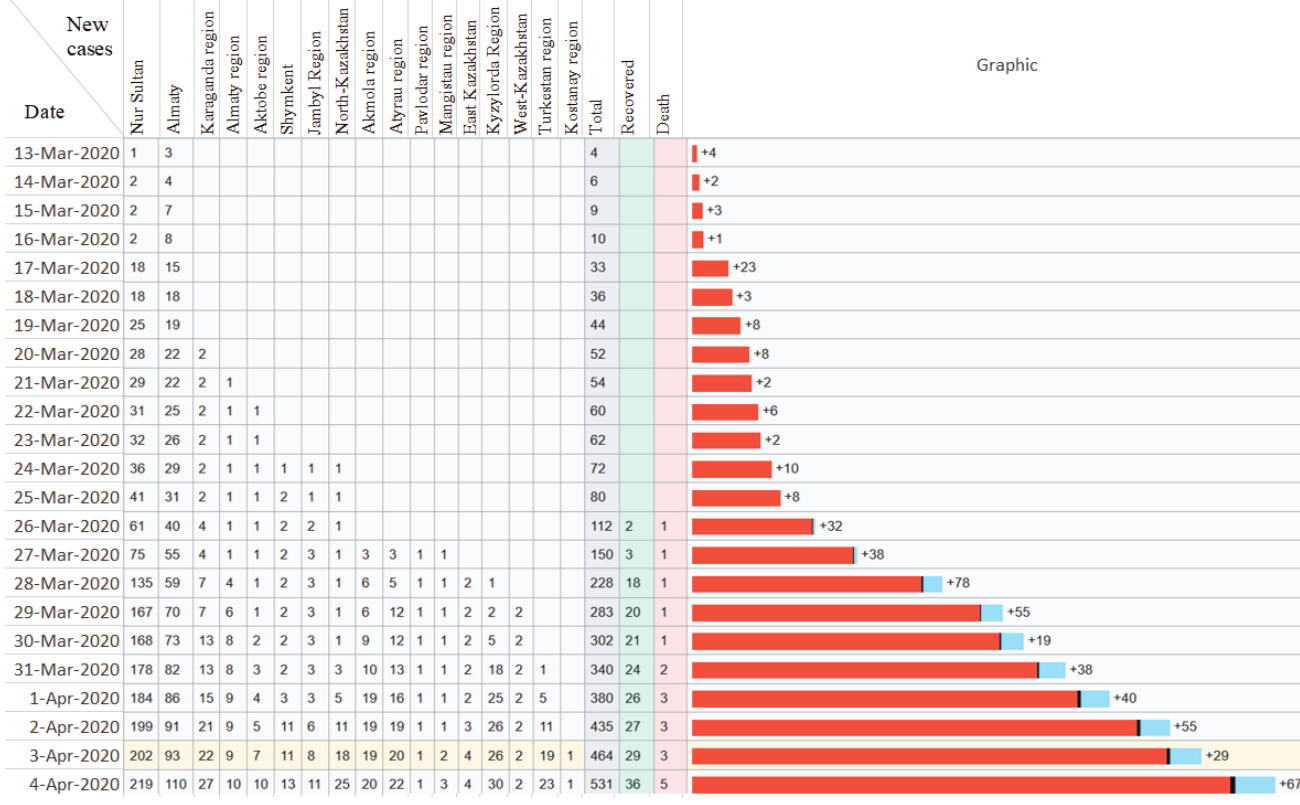
Figure 2 - The Overall graphic representation of new cases, number of recovered cases and death in Kazakhstan by regions and major cities